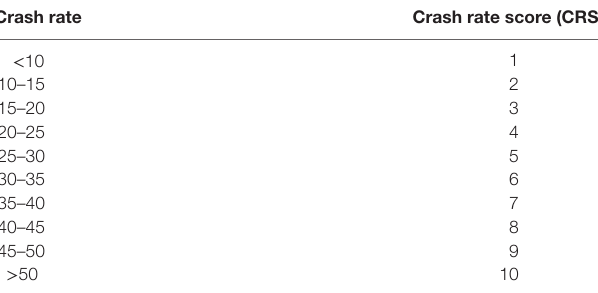
TaBle 4 | Crash experience scoring scheme.